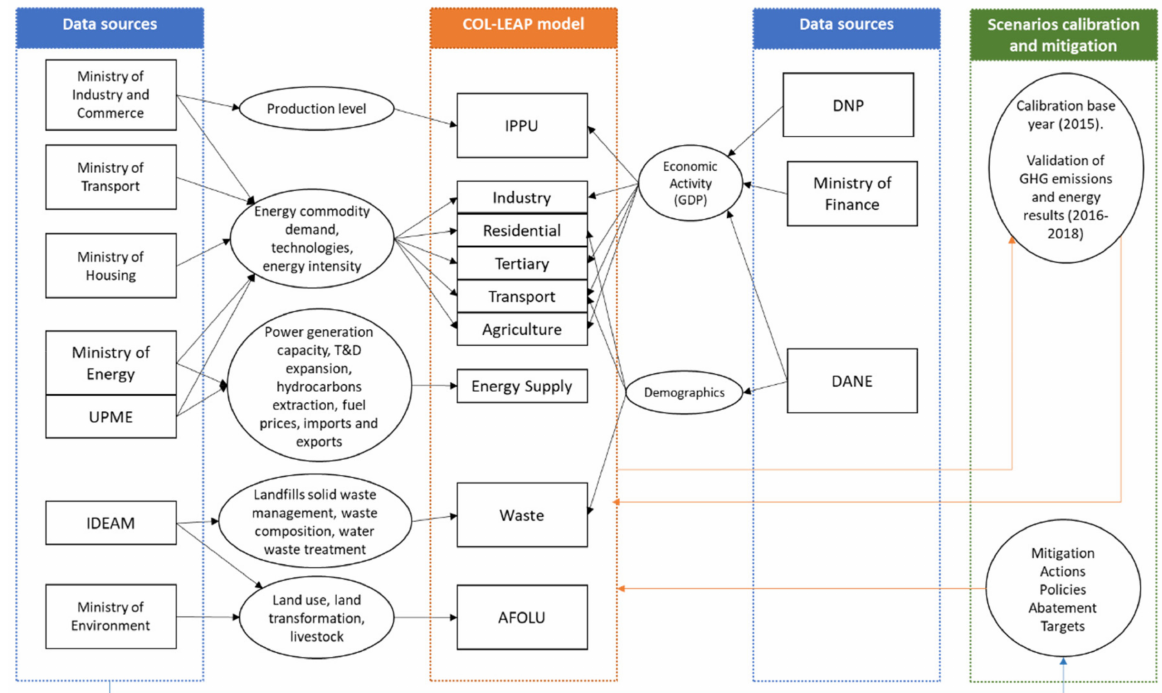
Figure 1. Stakeholders interactions and data exchange.